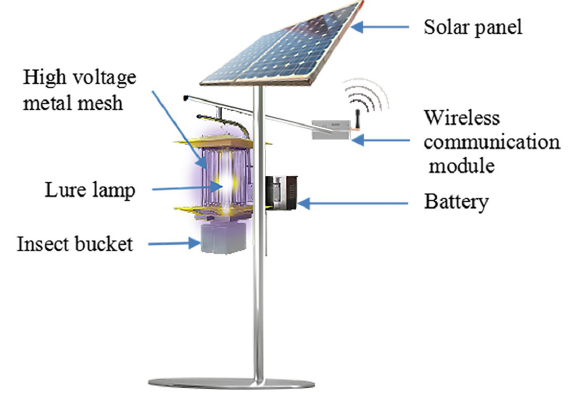
Figure 1. The SIL attracts migratory pests via a lure lamp in the evening and kills them by releasing high voltage pulse currents generated by the high voltage metal mesh. The dead pests are sorted in the insert bucket. The battery supplies the energy for the SIL. After being equipped with the wireless communication module, the SIL node can send its data to other